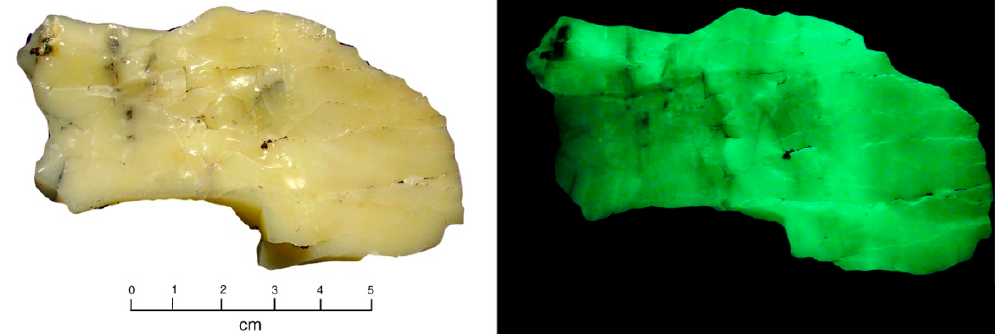
Figure 33. Uraniferous opal from uranium claim on hillside above Royal Peacock Mine headquarters. Location details canbe found in [21,22].